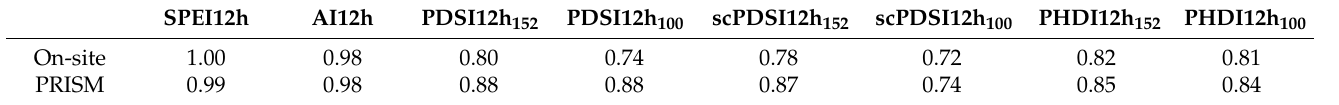
Table 3. Correlations between on-site and PRISM-parameterized drought indices and local streamflow.